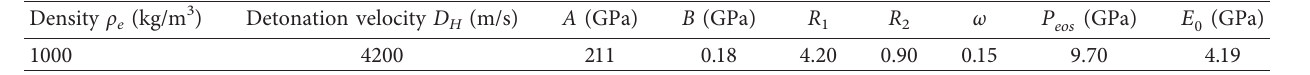
Table 1: Parameters of explosive in